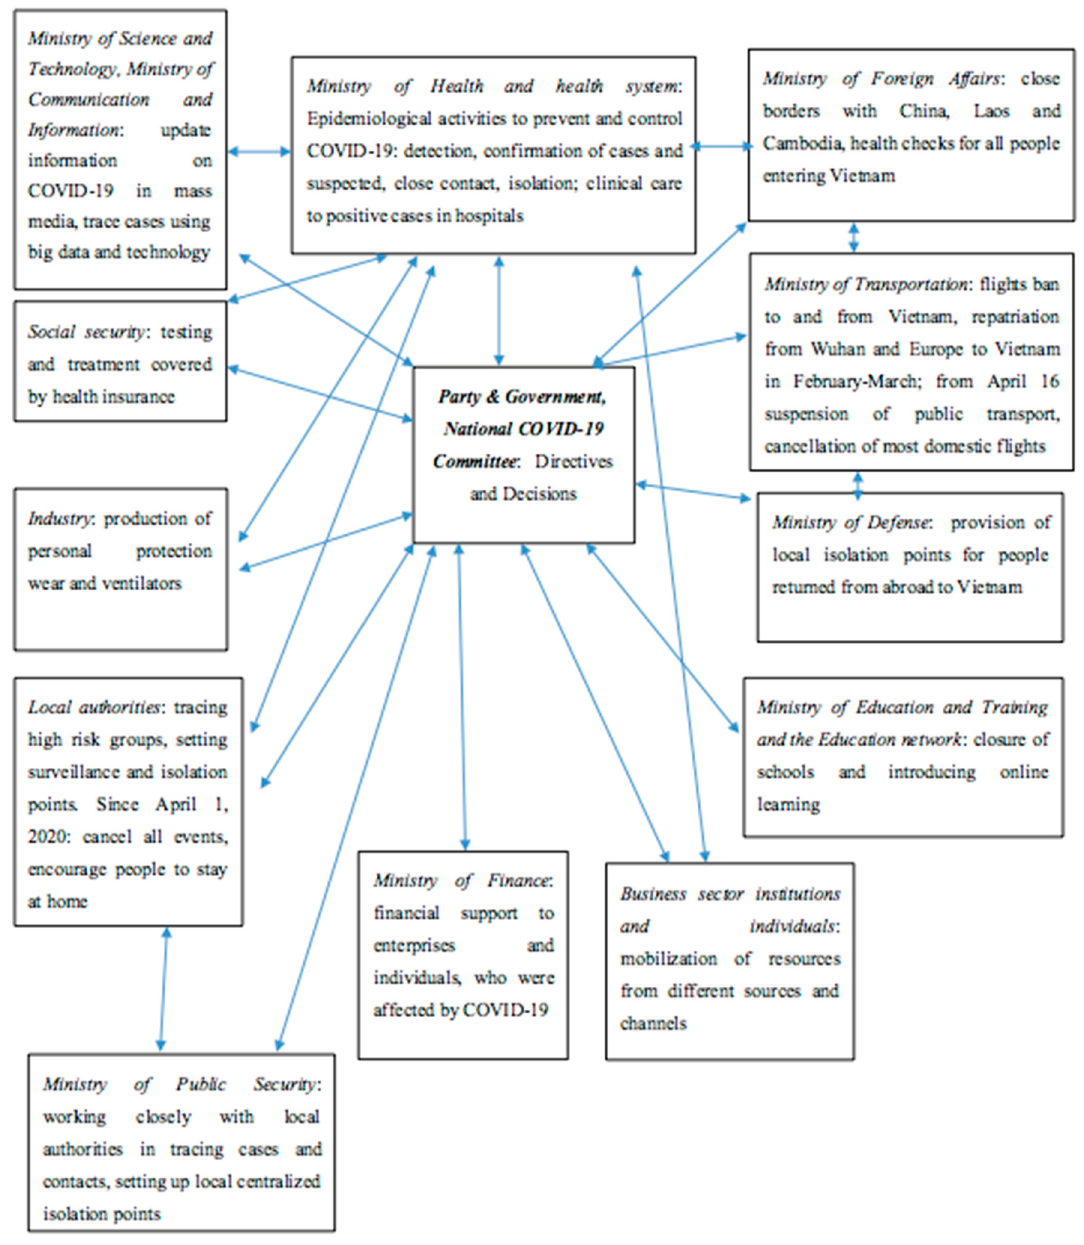
Figure 1. The coordinated national response to COVID-19 in Vietnam.